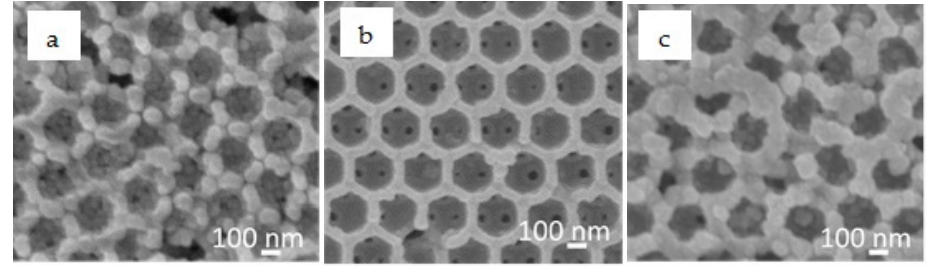
Figure 4. SEM images of CdSe QD deposited IO-TiO 2 without ZnS passivation ( a ); with 5 cycles of ZnS passivation ( b ); with 15 cycles of ZnS passivation ( c ).